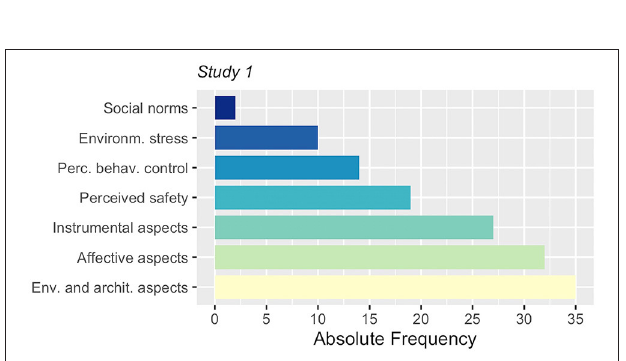
FIGURE 2 | Frequency of socio-psychological, environmental and architectural topics of the group discussions in Study